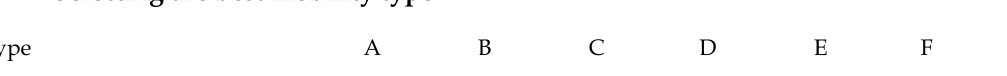
Selecting the best mobility